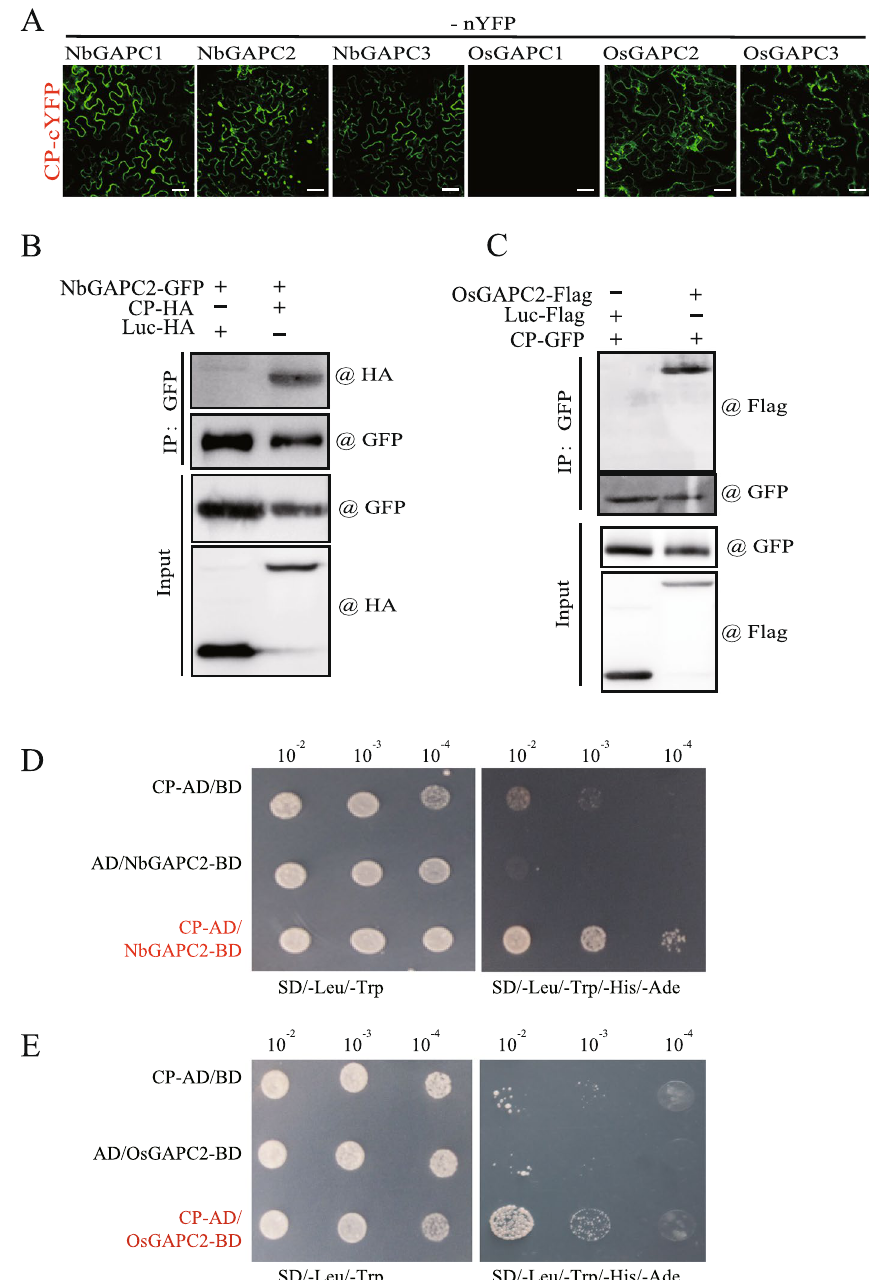
Fig. 2 RSV CP interacts with GAPCs. A BiFC assays to examine the interaction between RSV CP and GAPCs. RSV CP and GAPCs (NbGAPC1, NbGAPC2, NbGAPC3, OsGAPC1, OsGAPC2, and OsGAPC3) were fused to the N-terminal or C-terminal portions of the split yellow fluorescent protein (nYFP or cYFP, respectively) and transiently co-expressed in N. benthamiana . The reconstituted YFP fluorescence in epidermal cells was observed by confocal laser scanning microscopy. Scale bars, 20 μm. B and C In vivo co-immunoprecipitation assay to examine the interaction of CP with NbGAPC2 or OsGAPC2. RSV CP fused to an HA tag or GFP, NbGAPC2 fused to GFP, and OsGAPC2 fused to Flag were transiently expressed in N. benthamiana leaves, and immunoprecipitations were performed with an anti-GFP antibody. Protein samples before and after immunoprecipitation were analyzed by western blot with anti-HA, anti-Flag, and anti-GFP antibodies. D and E Yeast two-hybrid analysis of the interaction between CP and NbGAPC2 or OsGAPC2. The CP and NbGAPC2 or OsGAPC2 were inserted into pGADT7(AD) and pGBKT7(BD) plasmids. The combination plasmids were co-introduced into the yeast AH109 strain and cultured on a selective medium lacking SD-Leu-Trp and SD-Leu-Trp-His-Ade for 3–5